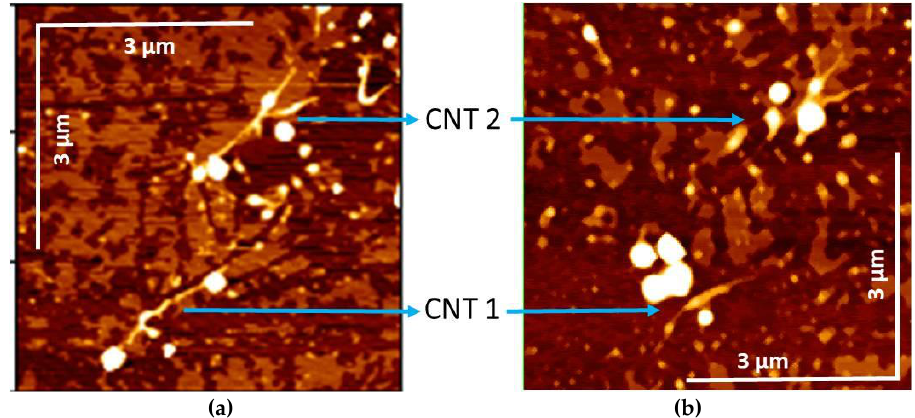
Figure 4. ( a ) Example of an AFM image of two isolated CNTs (or small bundles of SWCNTs) in presence of dispersed Au Nps in the surrounding. This area was after cleaned of dust and gold particles surrounding the SWCNTs to obtain the configuration displayed at right. ( b ) The same SWCNTs embellished with some Au Nps plasmonic molecules.